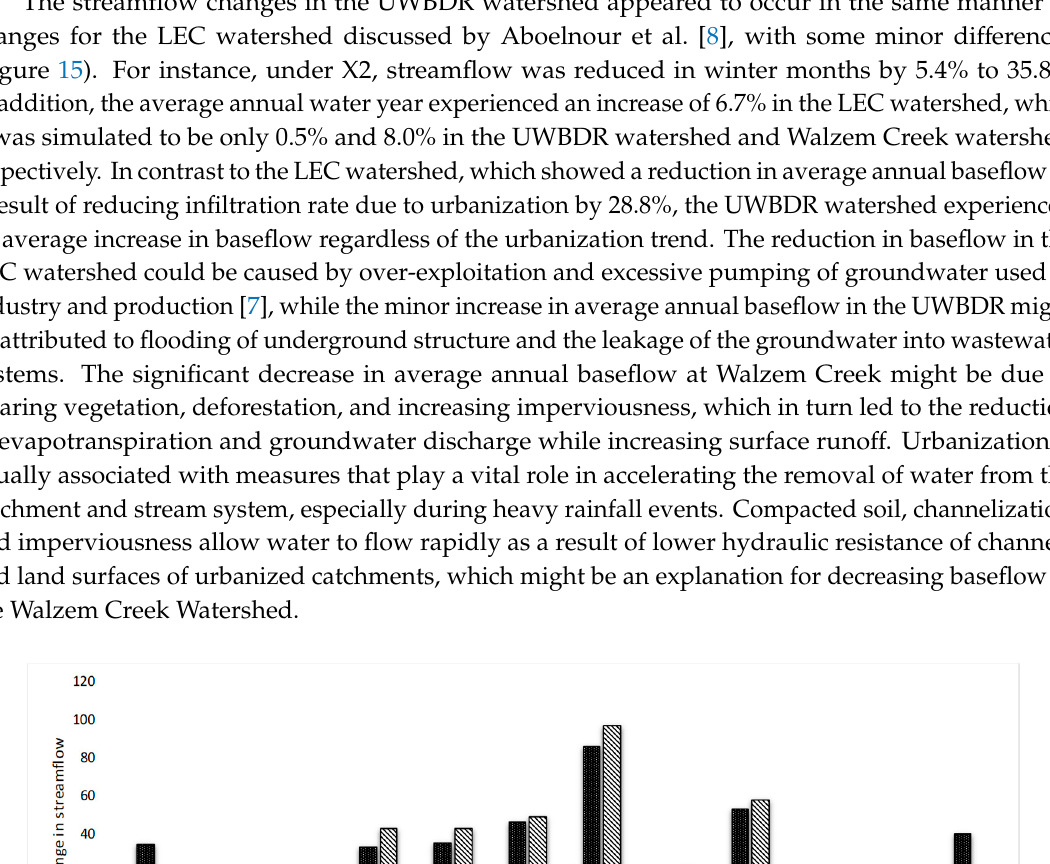
Figure 14. Monthly baseflow change for the Walzem Creek watershed under different scenarios.